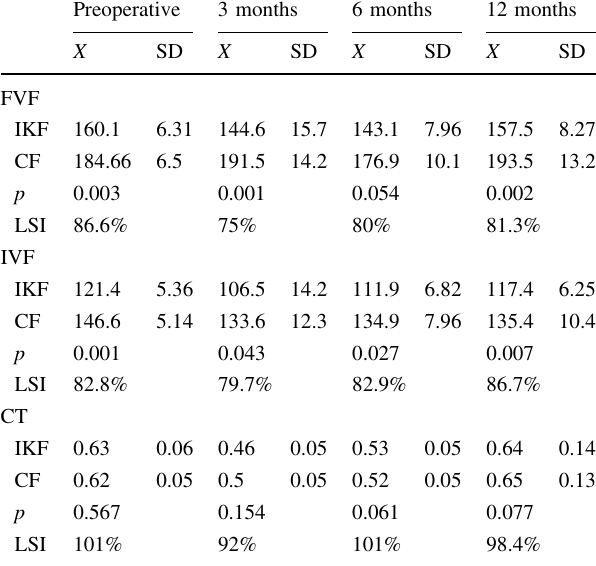
Table 5 Drop vertical jump kinetics Preoperative